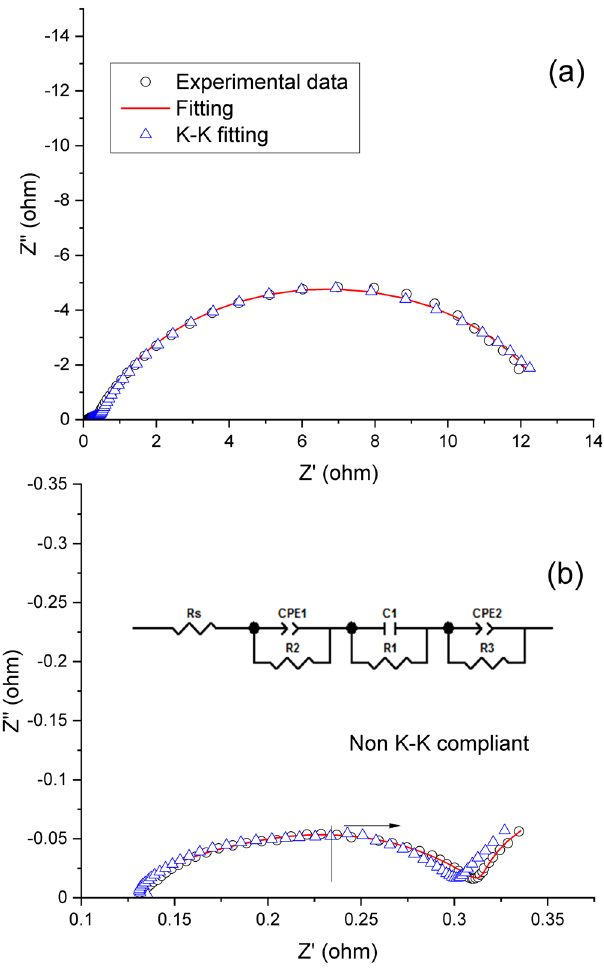
Fig. 2 Numerical fi tting and K – K fi tting of typical impedance spectrum. K – K (Kramers – Kronig) compliance is needed to ensure the linearity of the electrochemical system. a K – K compliant; b K – K non-compliant; The equivalent model was used to calculate the impedance points outside the measured frequency range. (reprinted from ref. 9 . Copyright © 2019, with permission from